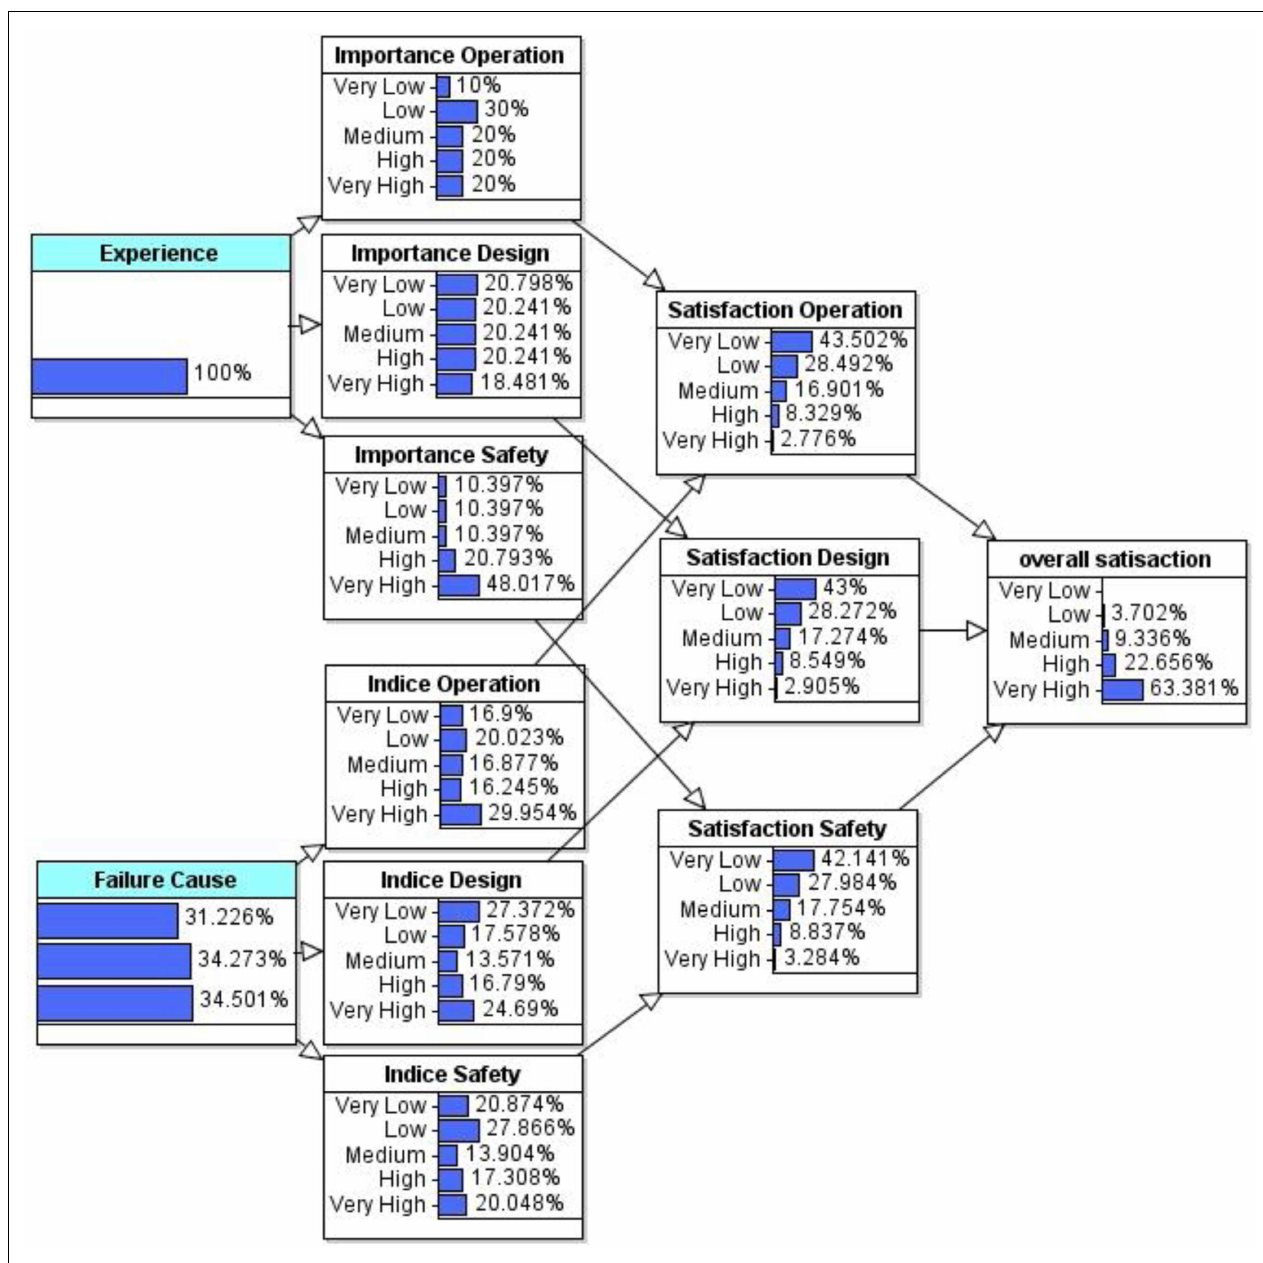
FIGURE 5 | Overall satisfaction in NPT